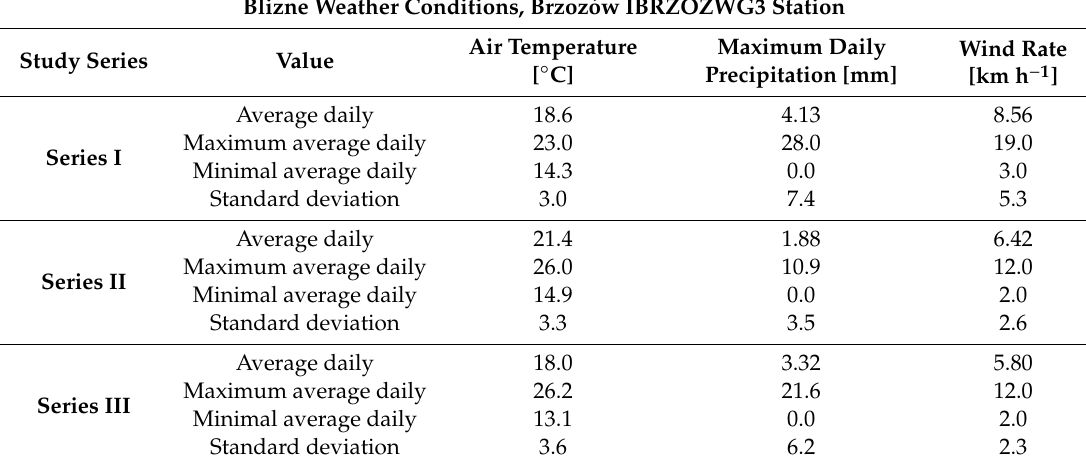
Table 3. Weather conditions during the study (own elaboration).